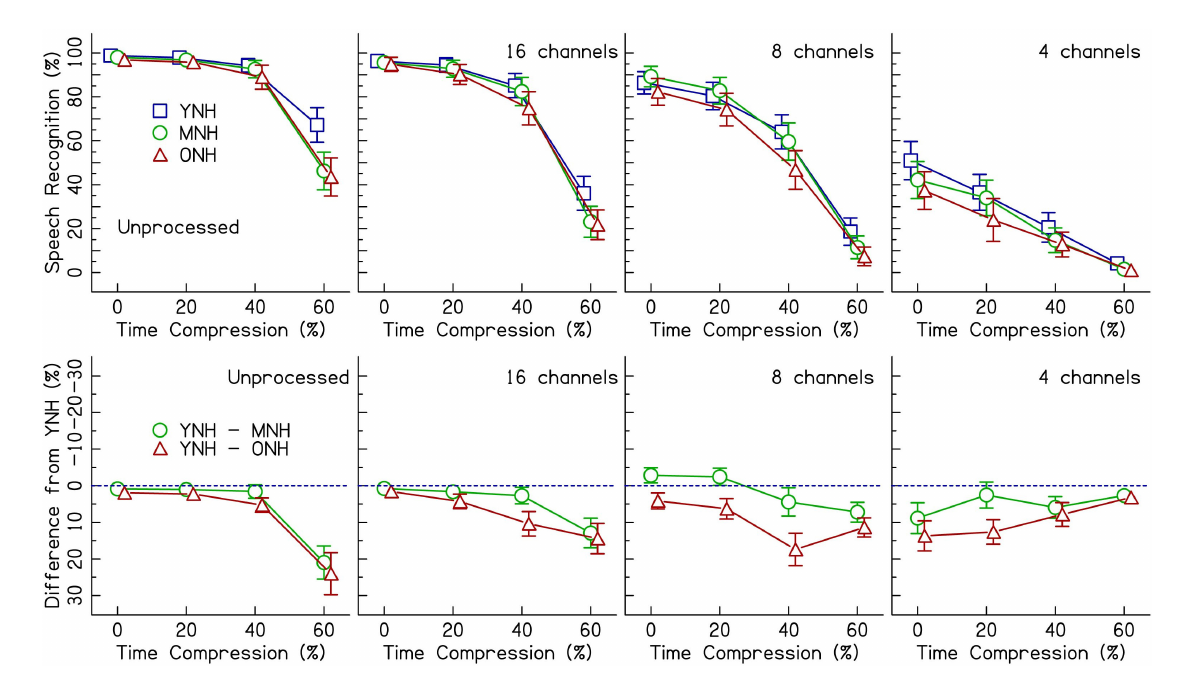
FIGURE2 The top row shows speech recognition performance in percent correct for listeners with normal hearing (NH) in three age groups (younger, middle-aged, and older) listening to various levels of vocoding (unprocessed, 16-channel, 8-channel, and 4-channel) and four rates of time compression (0, 20, 40, and 60%). Error bars show ± 1 standard error. The bottom row shows the difference from the performance of the younger age group in percent. The dotted blue line represents the performance of the younger listeners. Data points below the line represent worse performance than the younger group. Error bars show ± 1 standard error and are based on 10,000 bootstrapped